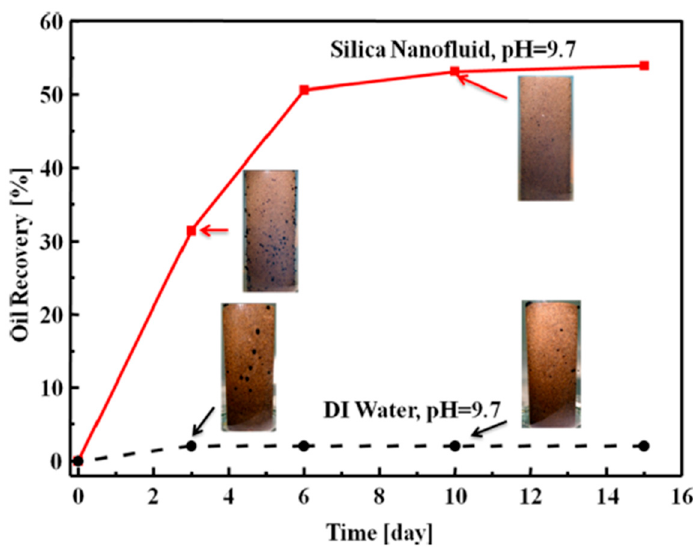
Figure 13. Imbibition of the silica nanofluid and pH 9.7 DI water into crude-oil-pre-saturated Berea sandstone at 25 °C. Reprinted with permission from [8]. Copyright 2014 American Chemical Society.